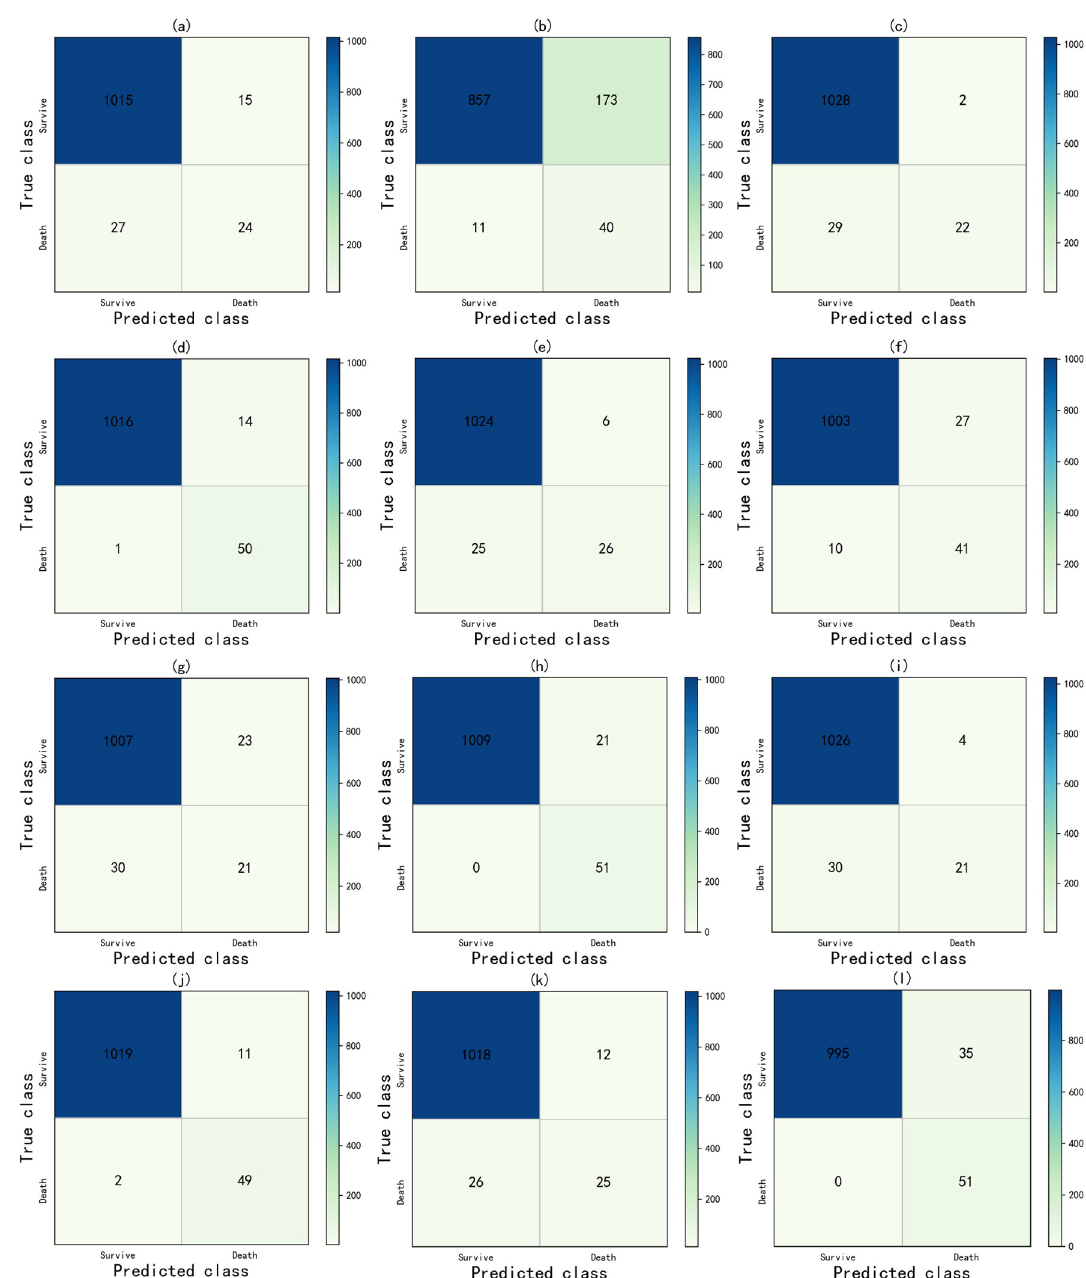
Fig 7. The confusion matrix includes. (1) only each prediction model after data preprocessing, where (a) LR, (c) RF, (e) GB, (g) DNN, (i) XGBoost, (k) CNN; and (2) each prediction model after using feature selection and mixed sampling techniques, where (b) LR, (d) RF, (f) GB, (h) DNN, (j) XGBoost, (l)